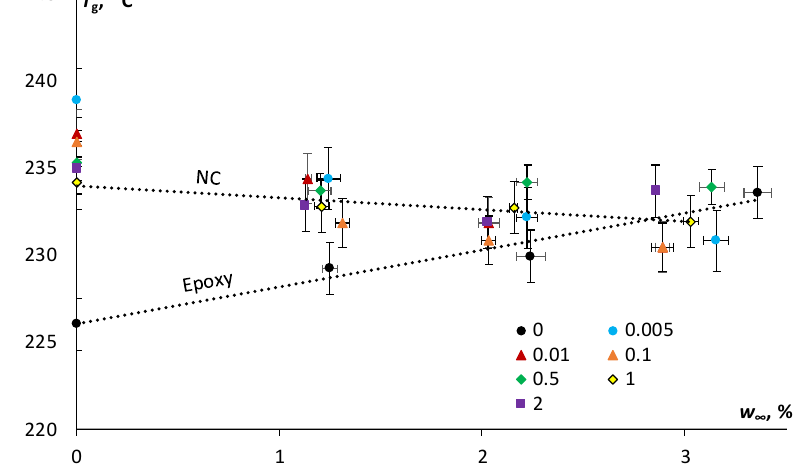
Figure 7. Glass transition temperature vs. desorbed moisture content after moisture absorption for epoxy and epoxy filled with N and SA MWCNTs (filler content is indicated in the legend). Dots—experimental data, lines—linear approximations for the epoxy and the NCs.